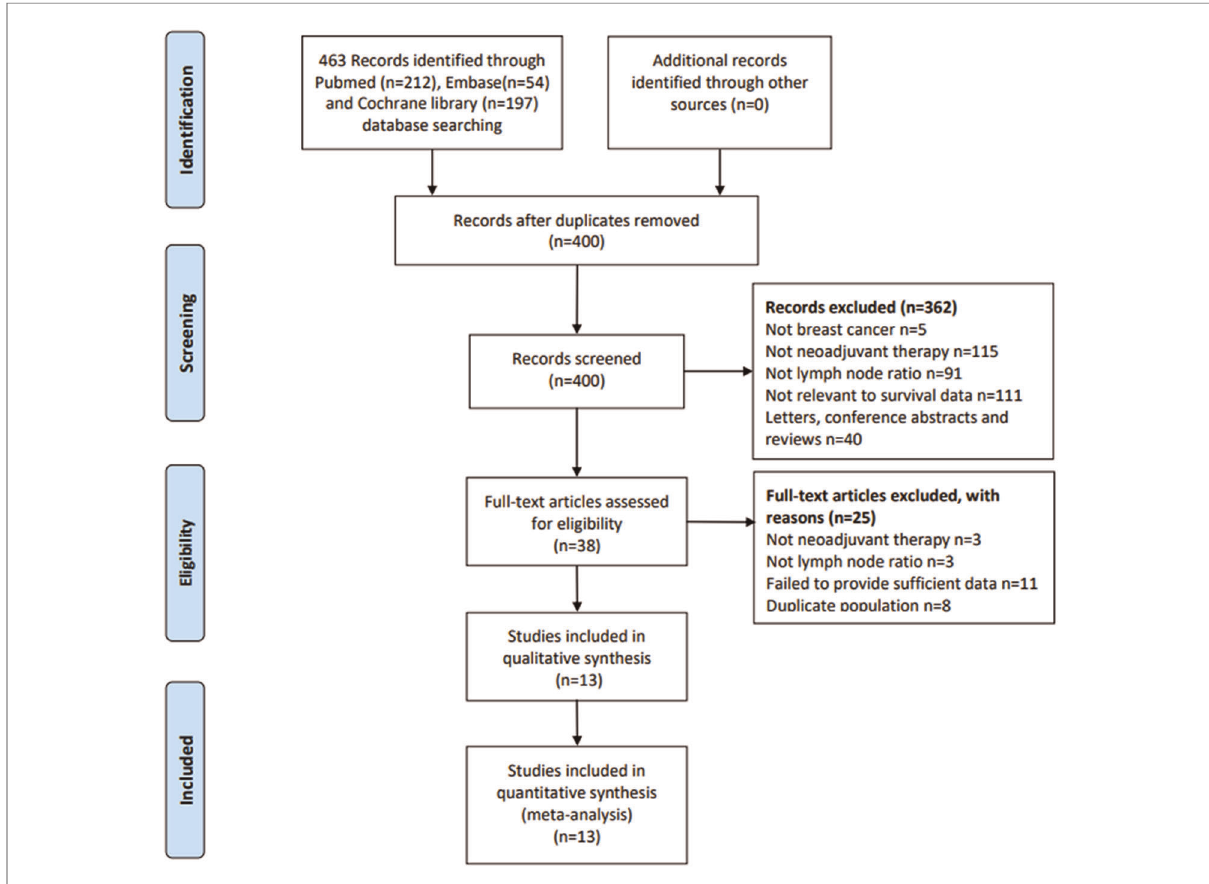
FIGURE 1 Flowchart of the study search and